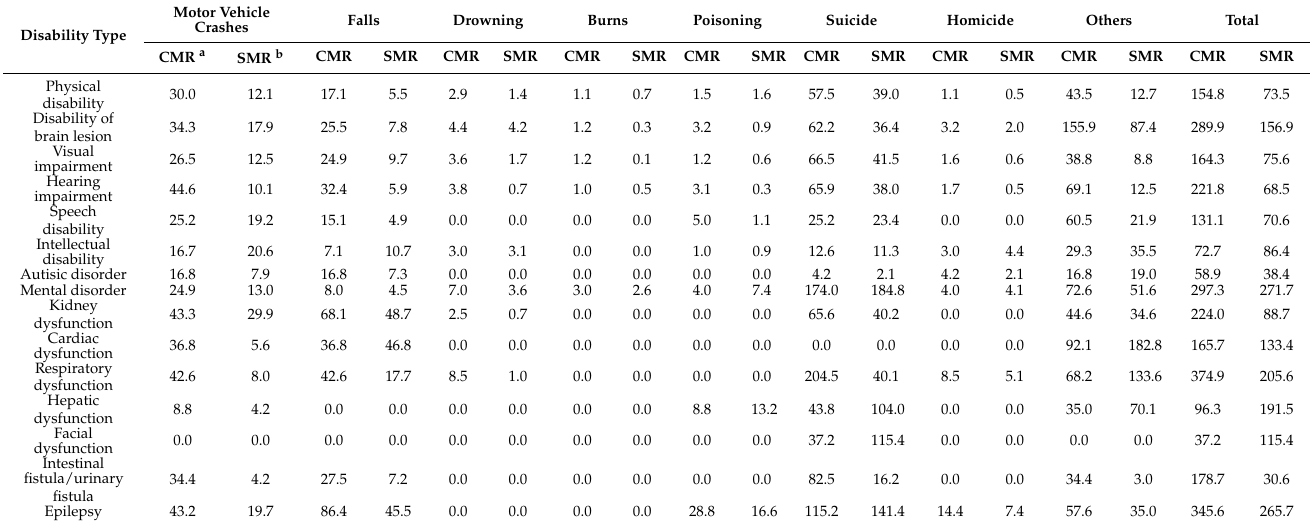
Table 3. Crude and age-adjusted mortality rates due to external causes of injury (ECIs) by type of disability, 2017 (unit: per 100,000